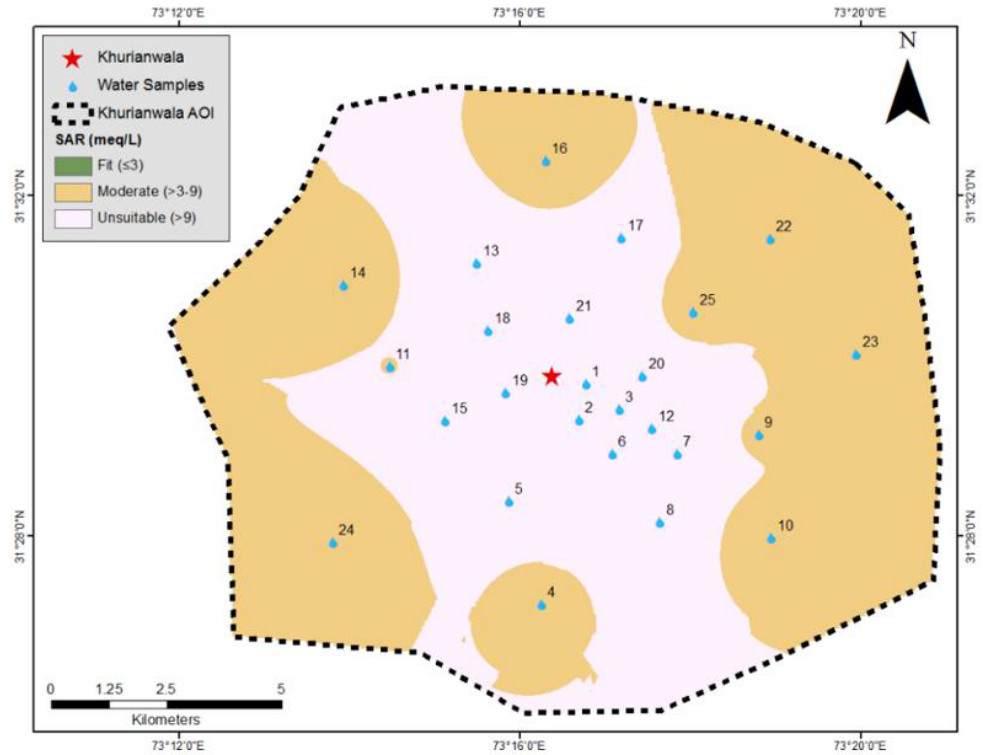
Figure 8. Mapping according to the distribution of SAR values based on irrigation water quality